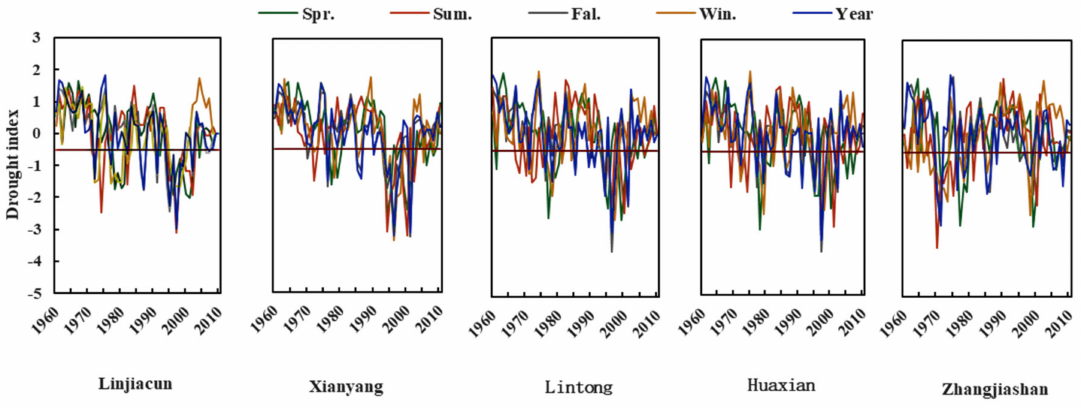
Figure 3. Annual and seasonal scale drought index variation curves by